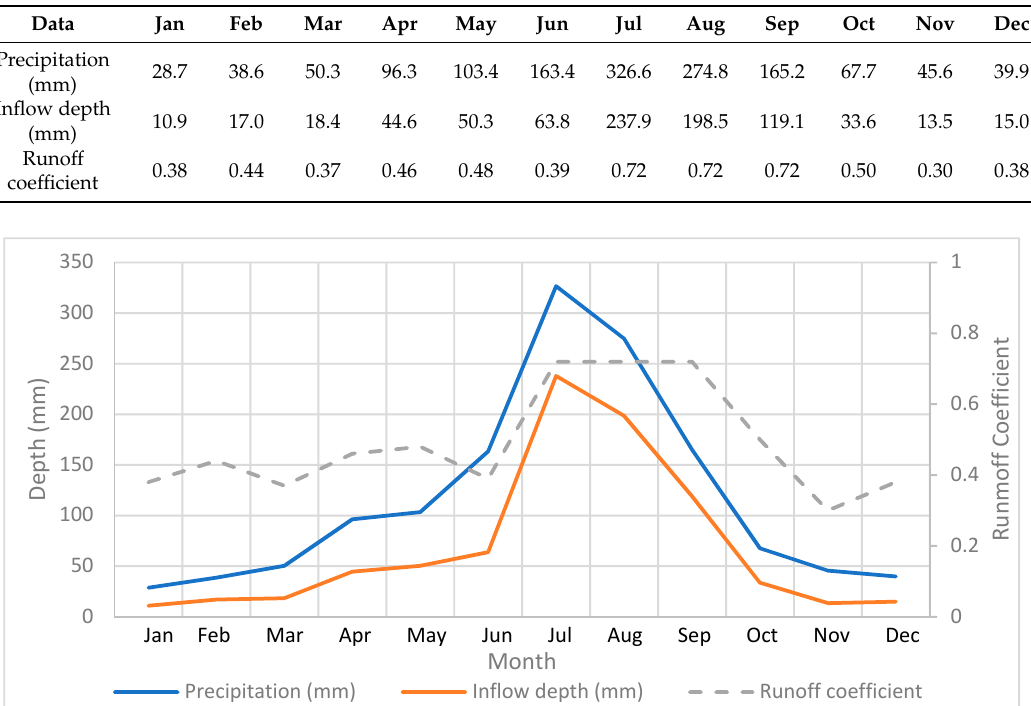
Figure 2. Monthly average precipitation, inflow depth and runoff coefficient of study area. We also used time series of many climatic indices available from the Climate Prediction Center [28] for the same period, which are updated monthly (Table 2). Table 2. List of teleconnection indices used in this study.